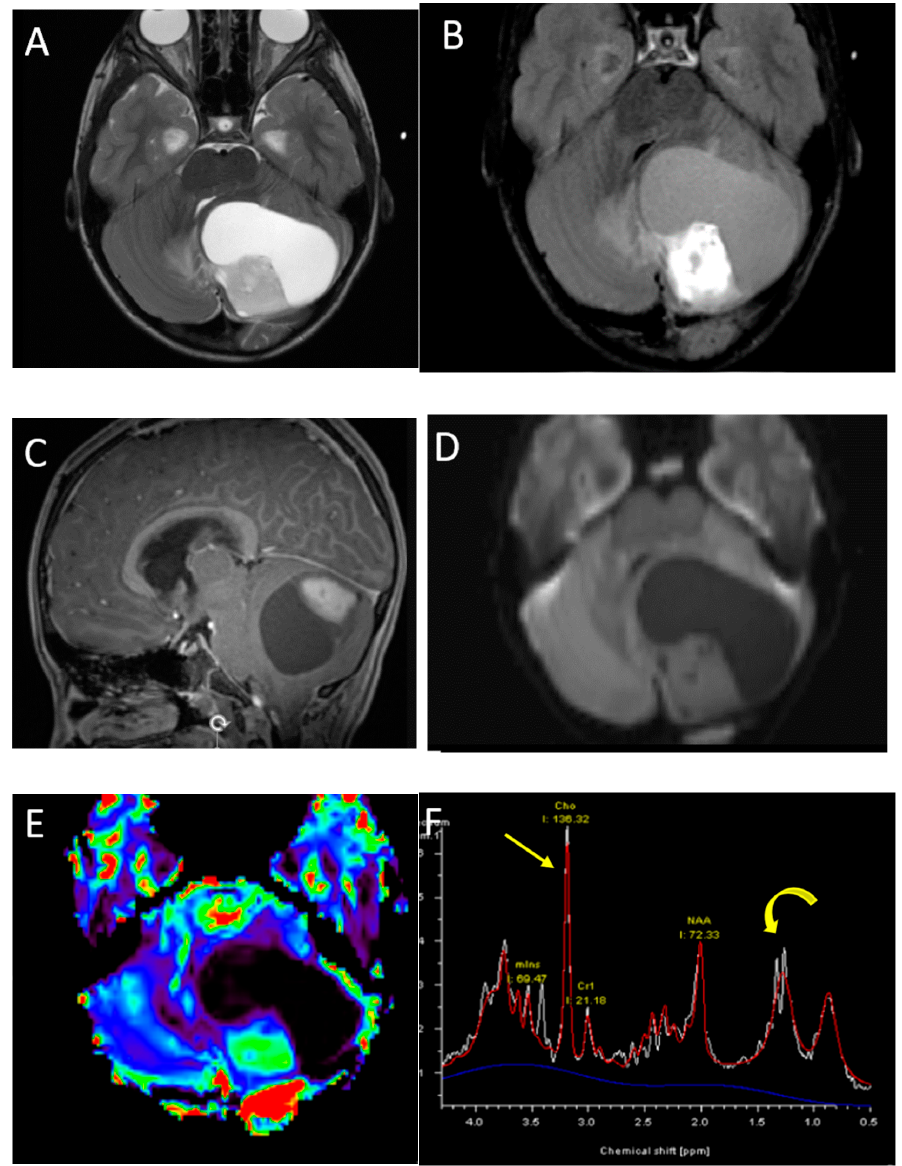
Figure 8. A 6-year-old boy with pilocytic astrocytoma. Axial T2 ( A ), post-contrast T2-FLAIR ( B ) sagittal post-contrast T1 ( C ) and axial DWI ( D ) images demonstrate a characteristic large cystic le- sion in the left cerebellar hemisphere with a solid nodule. The nodule enhances intensely without